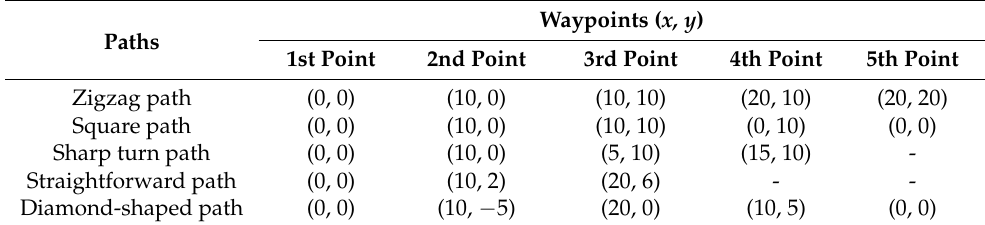
Table 7. Parameters of the paths used for simulation.